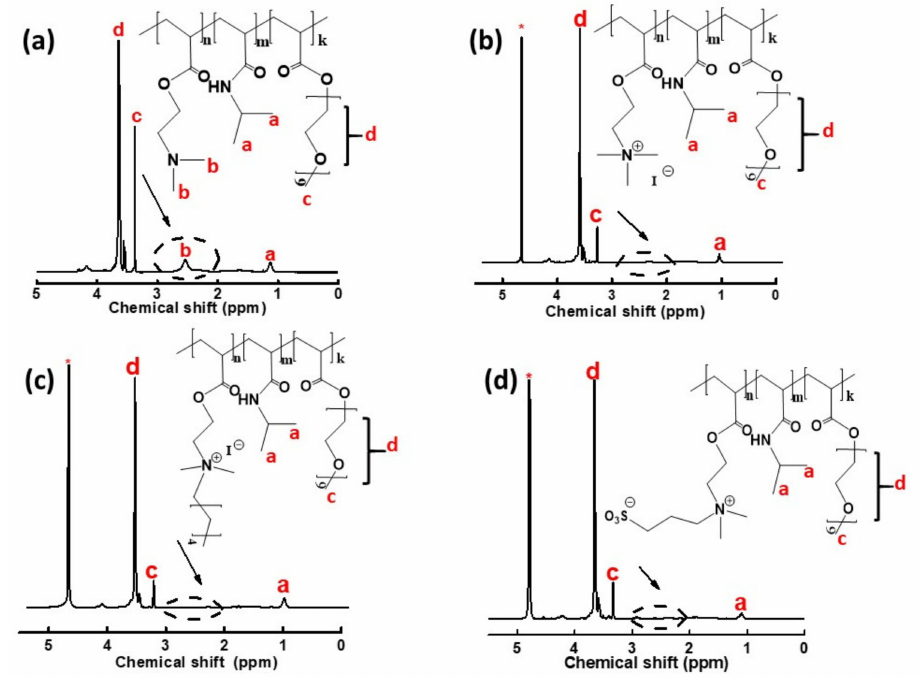
Figure2. 1 H-NMRspectrafor( a )PDMAEA 20 -b-PNIPAM 11 -b-POEGA 18 (inCDCl 3 ), ( b )QPDMAEA 20 -b- PNIPAM 11 -b-POEGA 18 (in D 2 O), ( c ) Q 6 PDMAEA 20 -b-PNIPAM 11 -b-POEGA 18 (in D 2 O), and ( d ) SPDMAEA 20 -b-PNIPAM 11 -b-POEGA 18 (in D 2